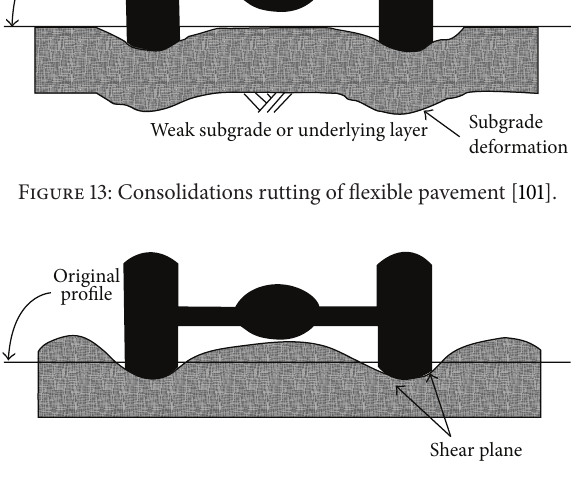
Figure 14: Instability rutting of flexible pavement